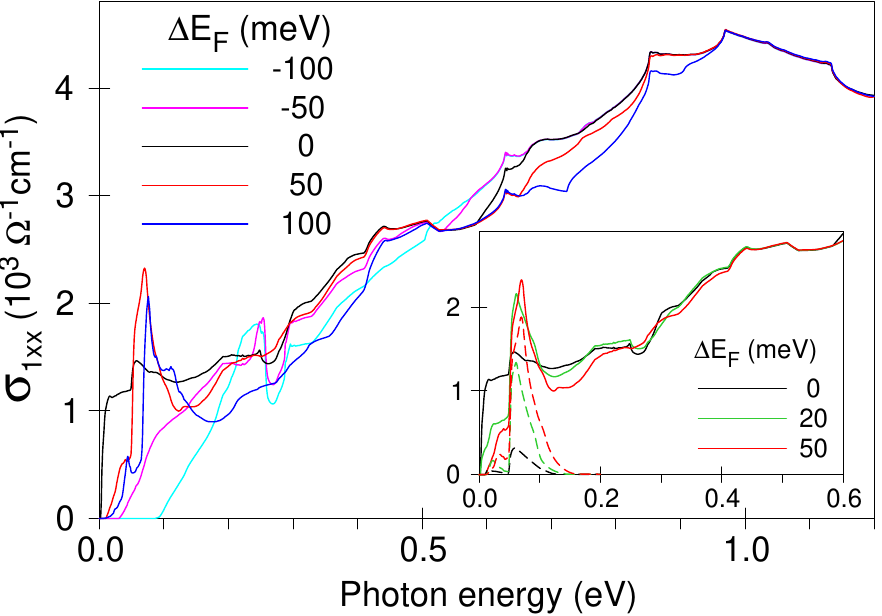
Figure 4. Low-energy optical conductivity of TaP calculated from its band structure. Lines of different colors correspond to different positions of the Fermi level, as indicated. The conductivity calculated for smaller positive ∆ E F is plotted in the inset. The contributions of 21 → 22 transitions are shown by dashed